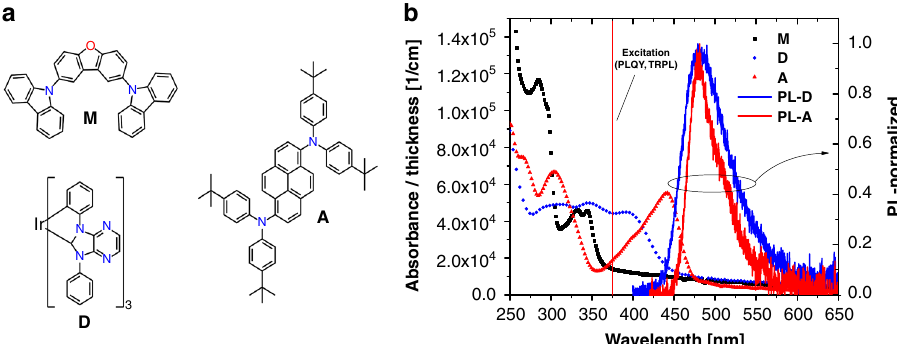
Fig. 2 Molecular structures and photophysical properties of the unicolored phosphor-sensitized fl uorescence system. a Molecular structures of the matrix, acceptor, and donor molecules. b UV – visible spectra of neat matrix, donor and acceptor layers on glass and normalized photoluminescence spectra of donor and acceptor in matrix. The red line shows the excitation wavelength of 375 nm used for the photoluminescent